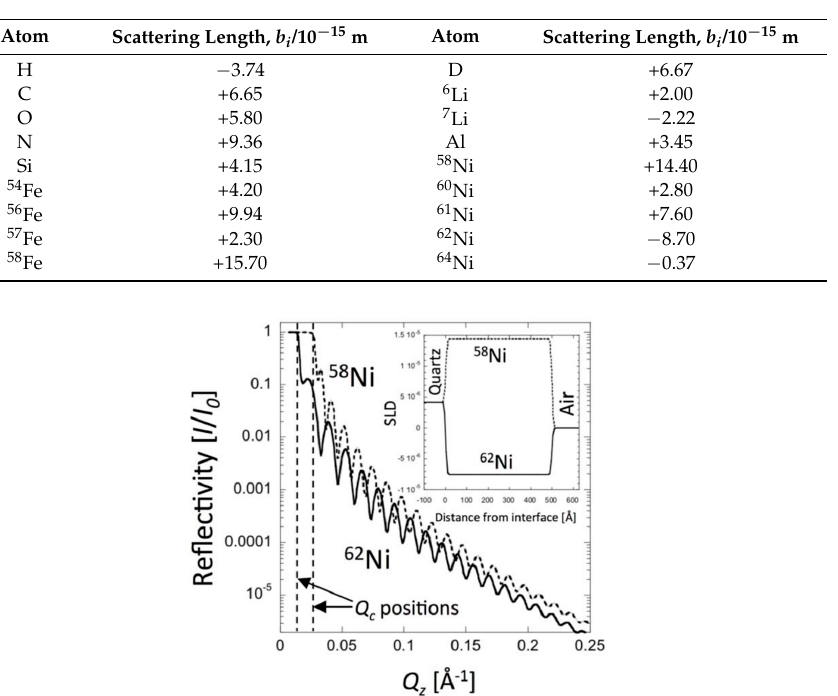
Table 1. Some scattering lengths for elements of particular interest in this context (those without the isotope specified are weighted by the natural abundance due to the lack of significant variation).